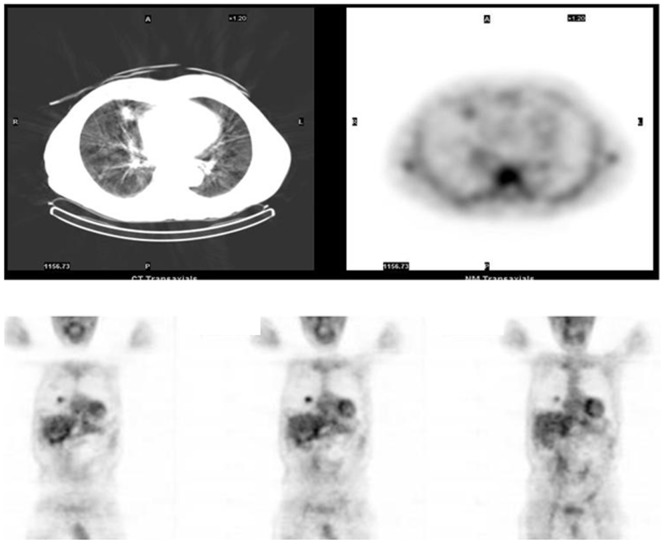
99mTc-depreotide scintigraphy (patient 10 in table 1) showing positive images of lung metastases.